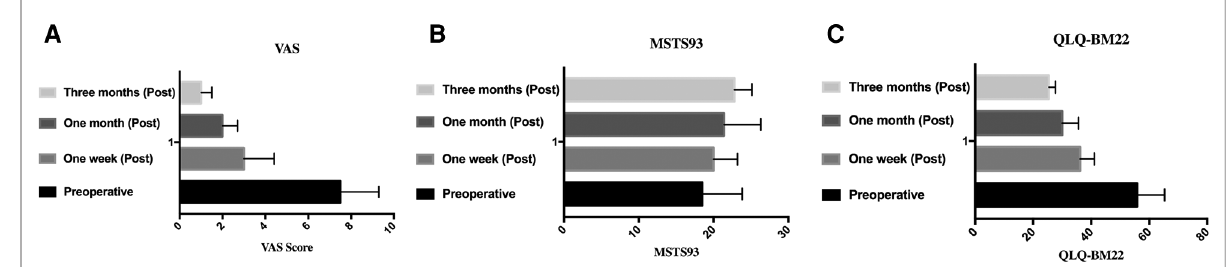
FIGURE 3 VAS, MSTS93, and QLQ-BM22 scores before and after operation. ( A ) VAS score in preoperative, 1 week, 1 month, and 3 months postoperative. ( B ) MSTS93 in preoperative, 1 week, 1 month, and 3 months postoperative. ( C ) QLQ-BM22 score in preoperative, 1 week, 1 month, and 3 months postoperative. VAS, visual analog scale.